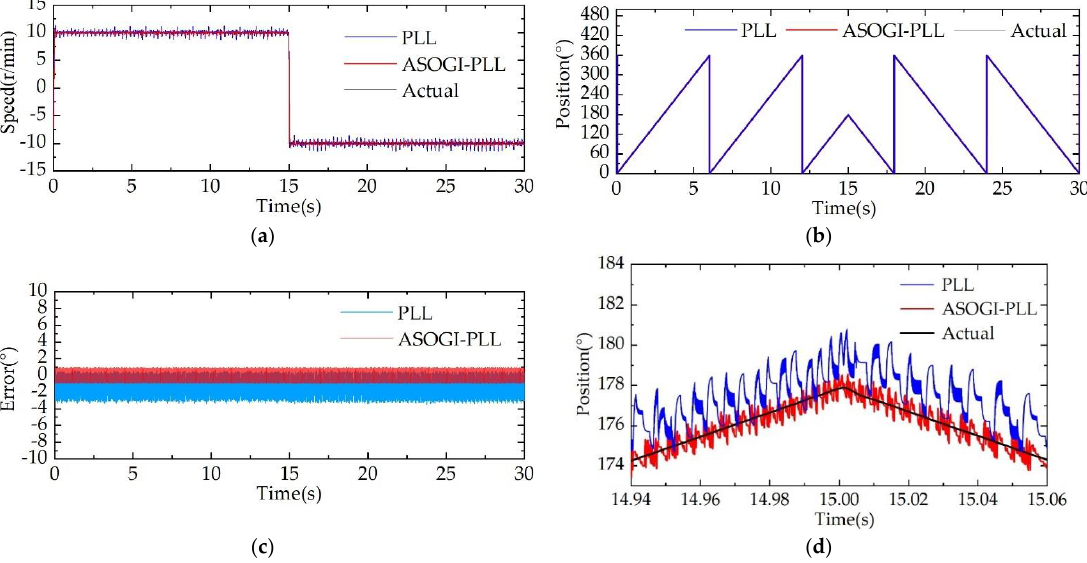
Figure 15. Rotor position waveform during motor reversal: ( a ) Speed waveform in reverse rotation; ( b ) Rotor position waveform; ( c ) Rotor position estimation error waveform; ( d ) Rotor position local enlarged waveform at t = 15